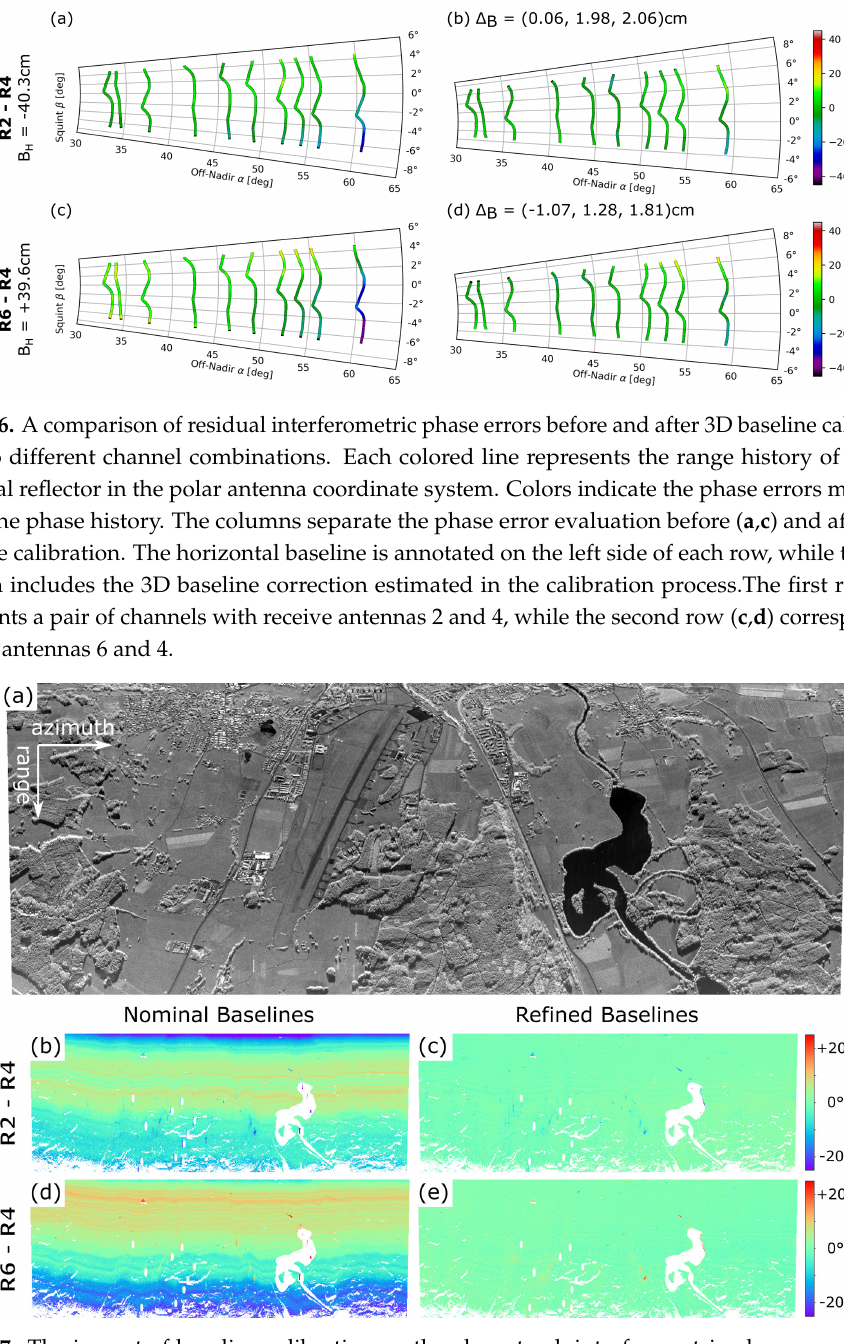
Figure 7. The impact of baseline calibration on the along-track interferometric phase measured in an acquisition of the V-SAR sensor over the calibration test site in Kaufbeuren, Germany: ( a ) the backscatter amplitude at X-ban; and ( b – e ) a matrix showing the along-track interferometric phase before and after baseline calibration (columns) for two of the five baselines (rows). The interferometric channel combinations shown as well as the 3D baseline corrections in ( b – e ) correspond to those of Figure 6a–d,